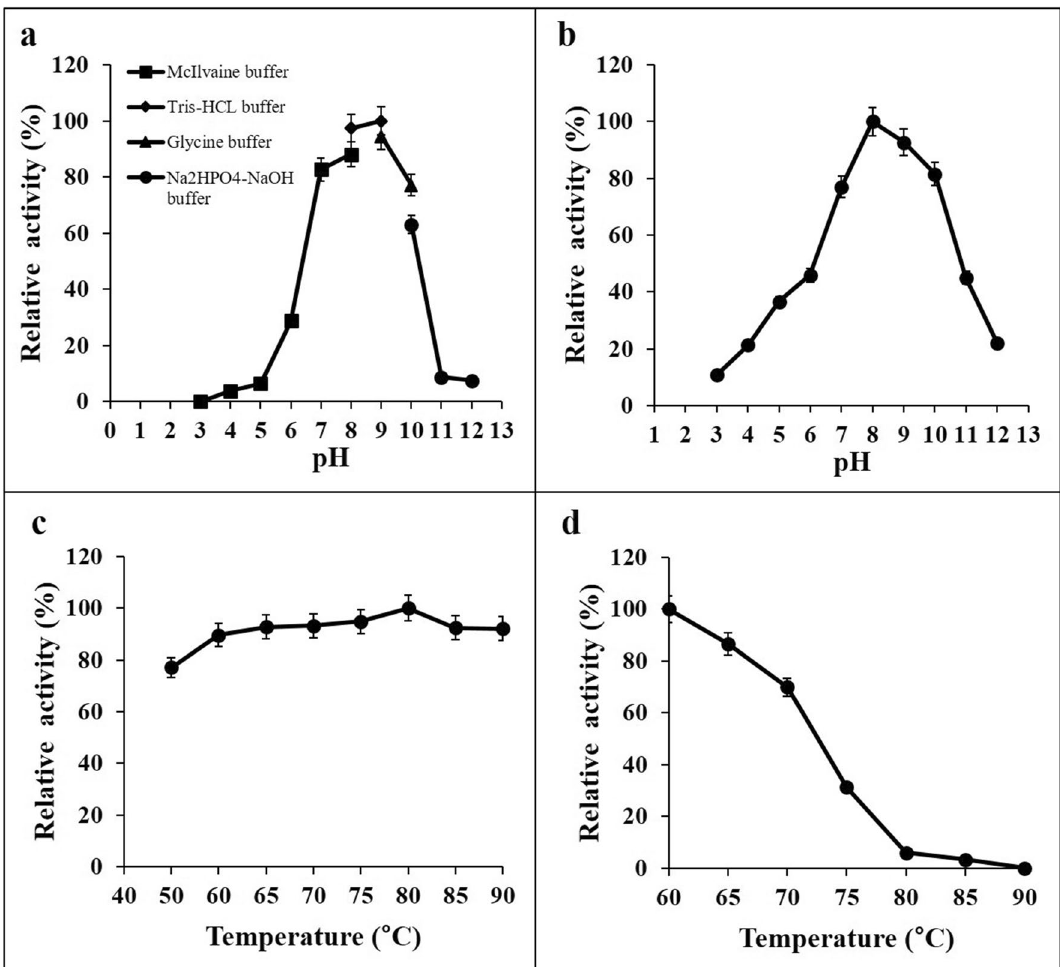
Figure 2. Effect of the optimum pH ( a ), the pH stability ( b ), the optimum temperature ( c ) and the thermal stability ( d ) of the endo-1,4-β-xylanase of Thermomyces dupontii